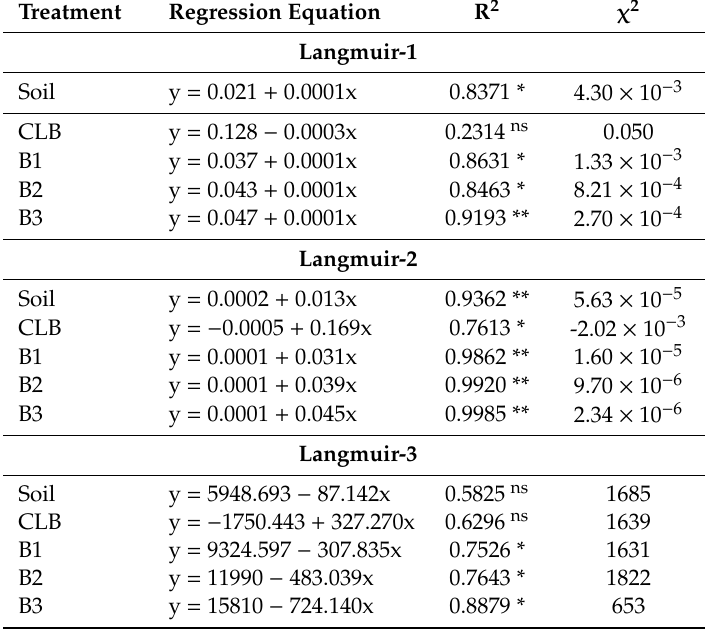
Table 14. Regression equations, Coe ffi cient of determination (R 2 ), and Chi-square analysis ( χ 2 ) for the fit of the Langmuir type 1, 2, and 3 isotherms to the phosphorus adsorption data of the